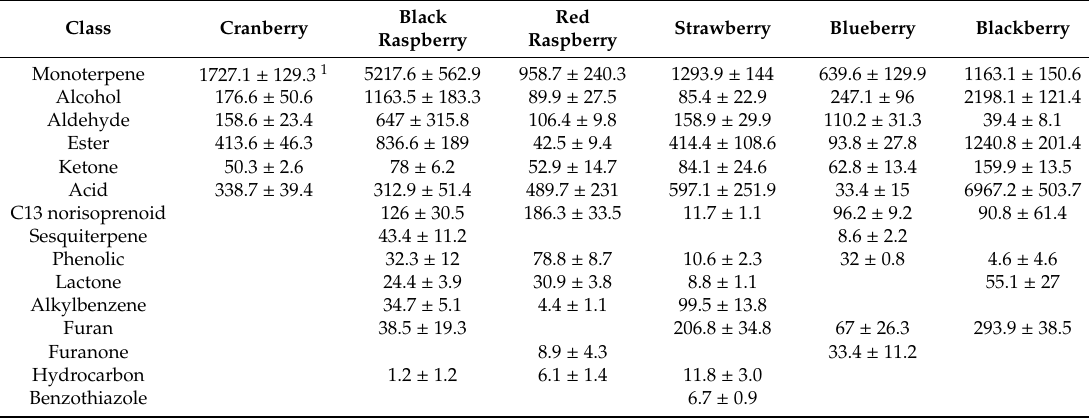
Table 2. The class composition of berry volatile extracts ( µ g /